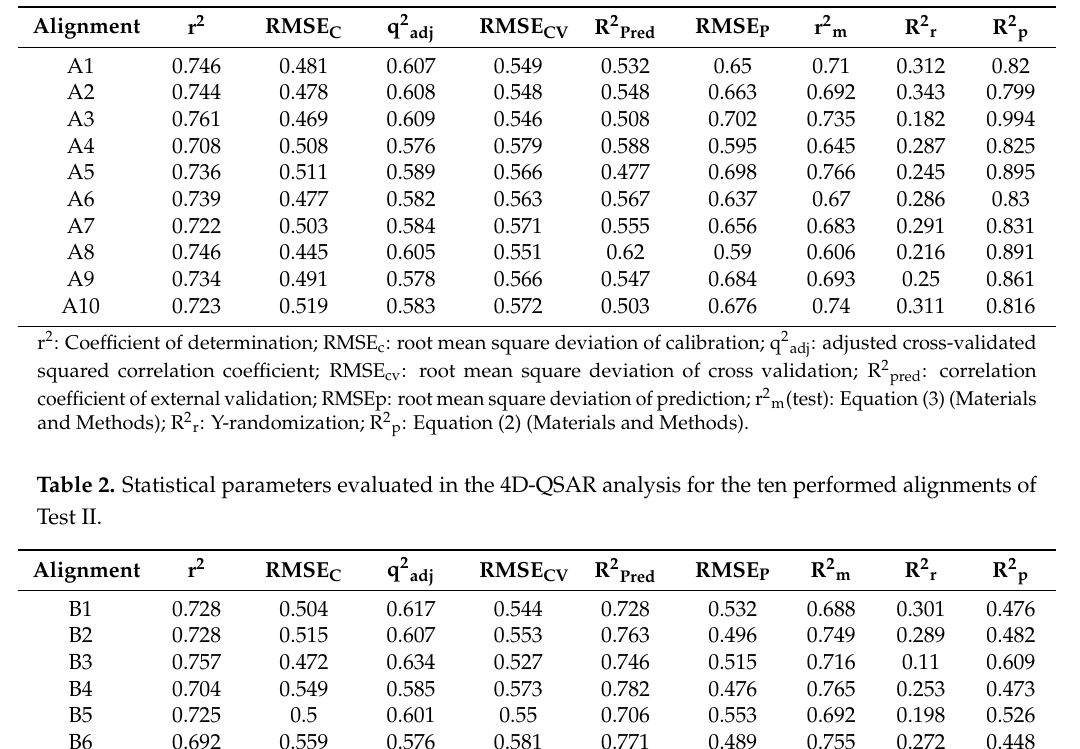
Table 1. Statistical parameters evaluated in the 4D-QSAR analysis for the ten performed alignments of Test I.